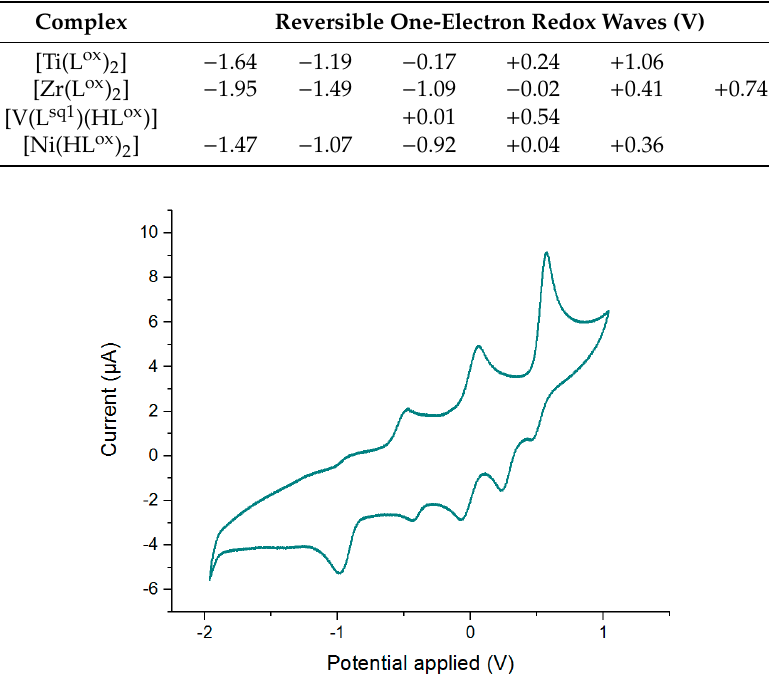
Table 3. Measured redox potentials for studied complexes (vs Fc + /Fc).